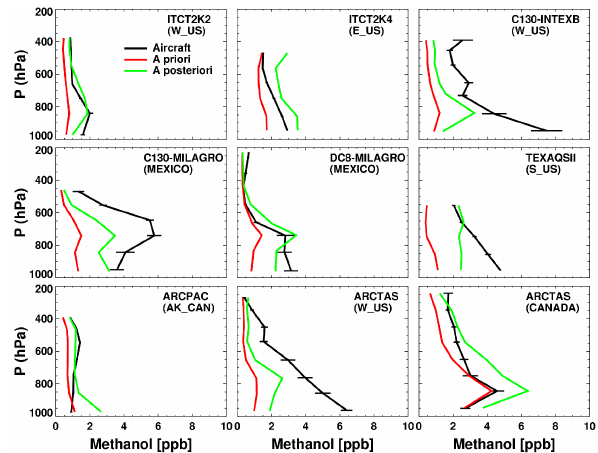
Fig. 8. Vertical profiles of methanol concentrations over North America. Each profile represents a campaign average over the re- gion specified in the panel. Aircraft measurements are shown in black with the ± 95% confidence limits for each vertical bin indi- cated by the horizontal bars. The red line is the a priori GEOS-Chem simulation, and the green line is the GEOS-Chem simulation after a posteriori scaling factors have been